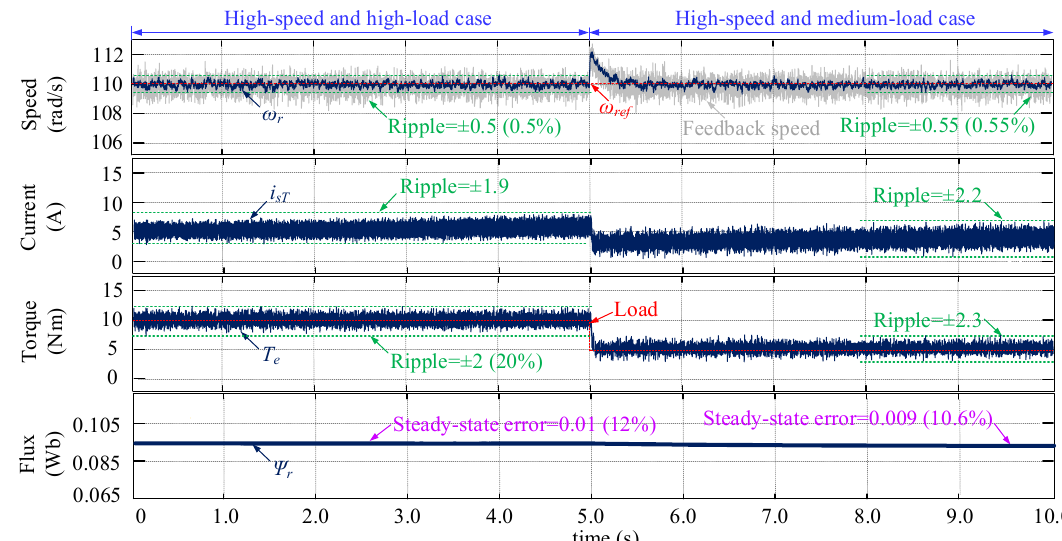
Figure 10. Performance of traditional FCS-MPTC with fixed PI parameters and fixed weighting factor.